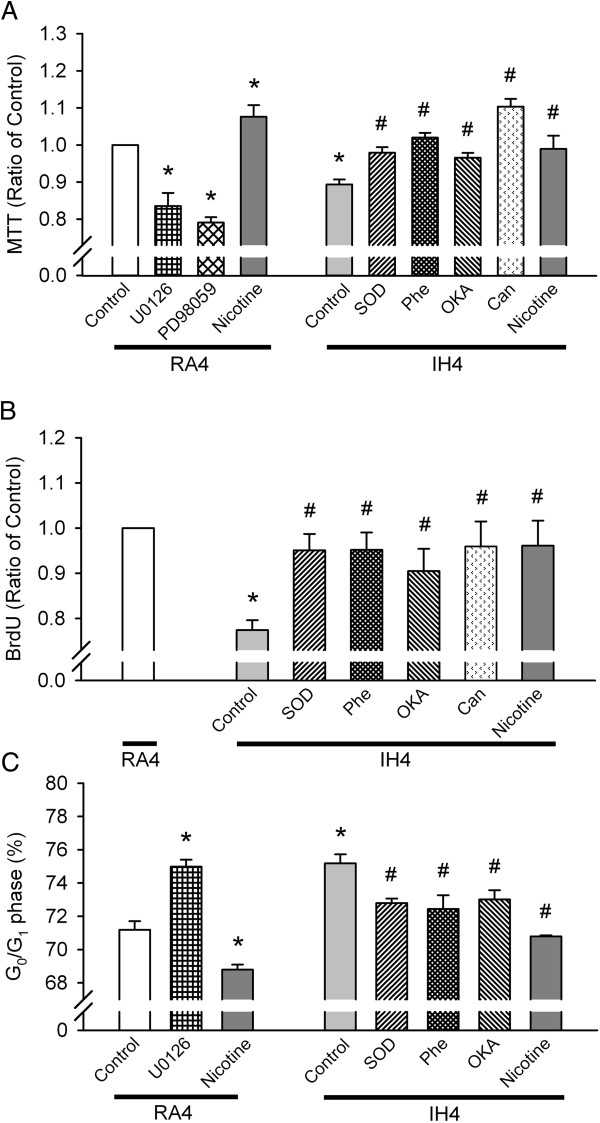
Effect of intermittent hypoxia (IH)-induced ROS generation on PP2A activation and downregulated ERK1/2 activation leading to PC12 cell proliferation inhibition. (A) PC12 cell numbers determined by MTT assay after exposure to normoxia for 4 days (RA4, control, n = 16), and RA4 along with the ERK1/2 phosphorylation inhibitors U0126 (n = 8) and PD98059 (n = 7), the ERK1/2 phosphorylation activator nicotine (n = 14), and exposed to IH for 4 days (IH4, control, n = 8), IH4 along with superoxide dismutase (SOD, n = 12), the PP2A activation inhibitors 1,10-phenanthroline (Phe, n = 12), okadaic acid (OKA, n = 9) and cantharidin (Can, n = 9) and nicotine (n = 9). (B) PC12 cell proliferation determined by BrdU cell proliferation ELISA assay kit after exposure to RA4 (n = 8), IH4 (control, n = 8) and IH4 along with SOD (n = 7), Phe (n = 7), OKA (n = 7), Can (n = 7) and nicotine (n = 6). (C) Percentages of PC12 cells in G0/G1 phase arrest as determined by propidium iodide staining and flow cytometry after exposure to RA4 (control, n = 8), RA4 along with U0126 (n = 4), RA4 with nicotine (n = 4), IH4 (control, n = 7), IH4 along with SOD (n = 6), Phe (n = 5), OKA (n = 5) and nicotine (n = 4). *p < 0.05 compared with RA4. #p < 0.05 compared with IH4. Values are means ± SEMs.